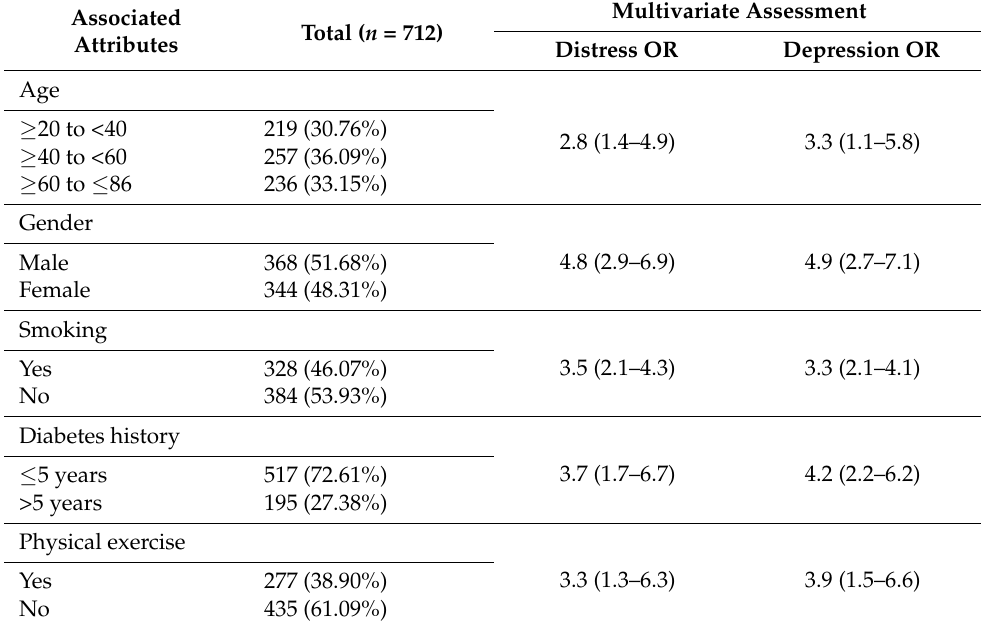
Table 5. Regression assessment of significantly associated